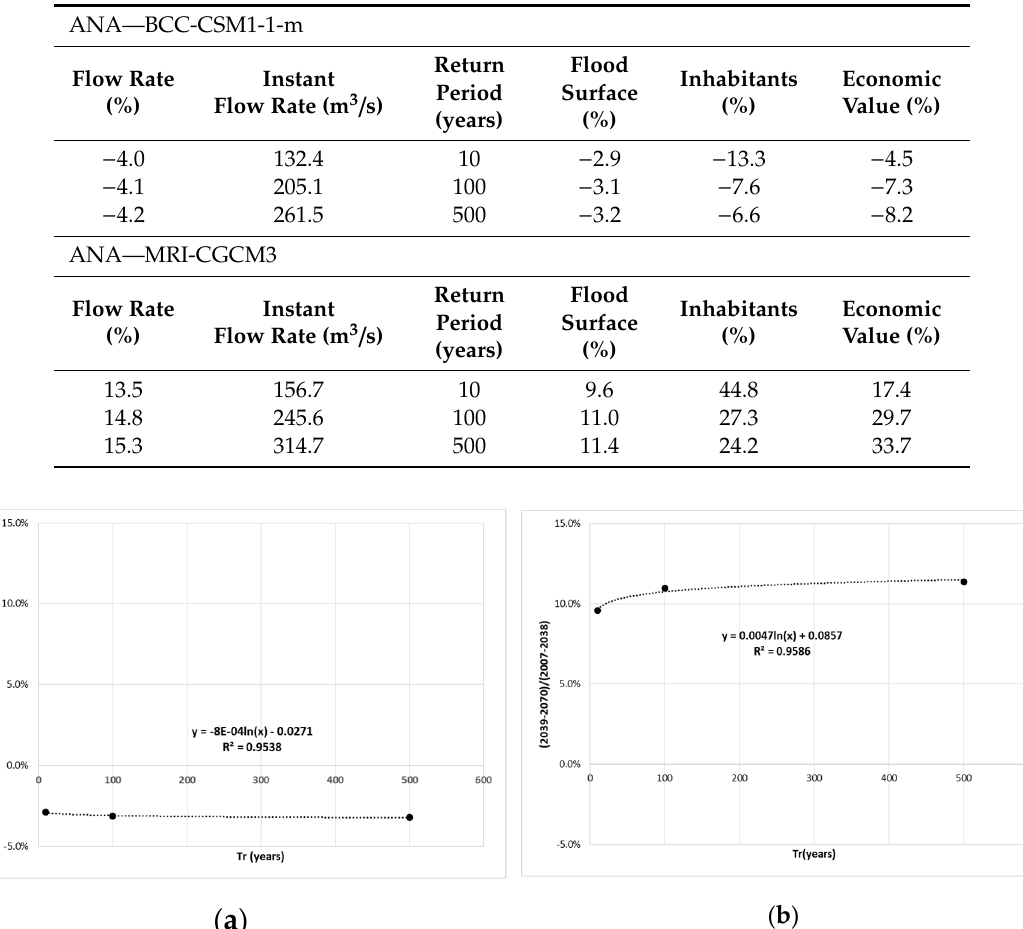
Figure 12. Second Stage (2039–2070)/1st Stage (2007–2038) flood surface ratio trend line in terms of